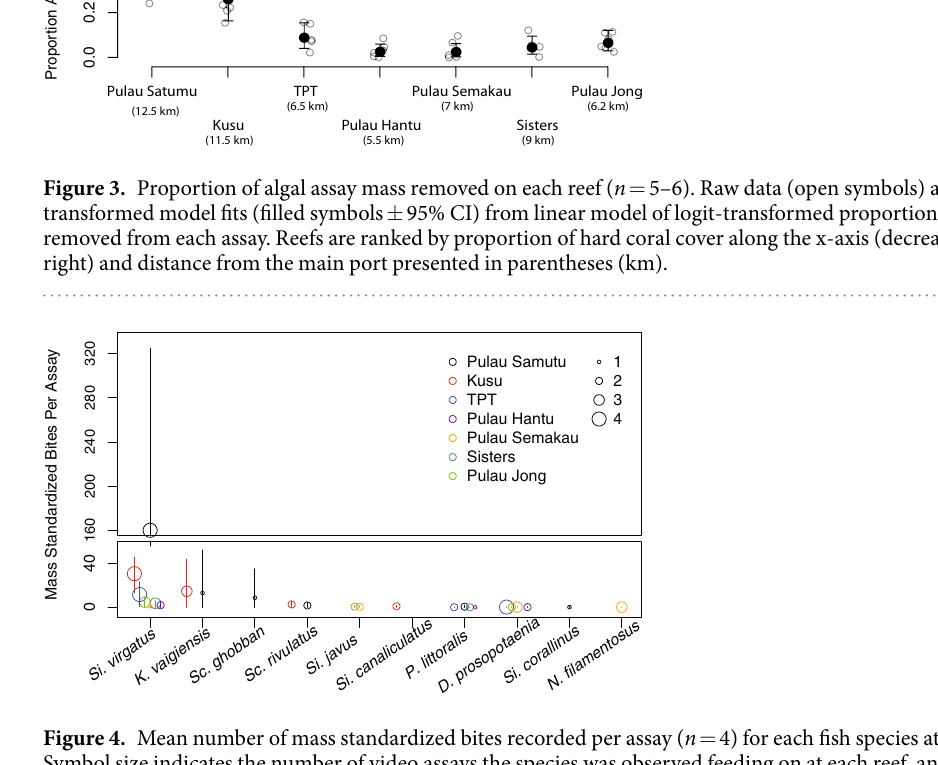
Figure 4. Mean number of mass standardized bites recorded per assay ( n = 4) for each fish species at each reef. Symbol size indicates the number of video assays the species was observed feeding on at each reef, and whiskers represent the data range. Species are ranked by total mass standardized bites along the x-axis (decreasing left to